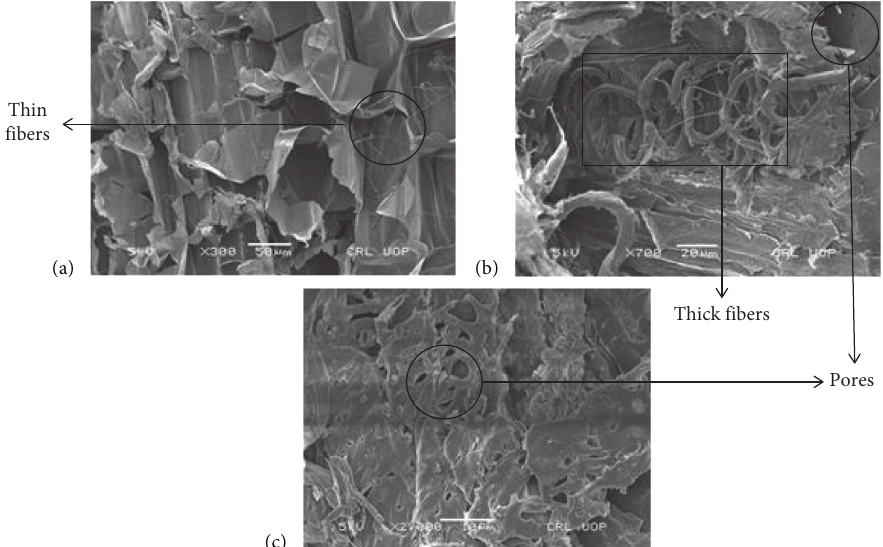
Figure 3: SEM of inner core of corn stalk: (a) Longitudinal section (foliated texture). (b) X-section at internodes (fibrous texture). (c) X-section near nodes (layered